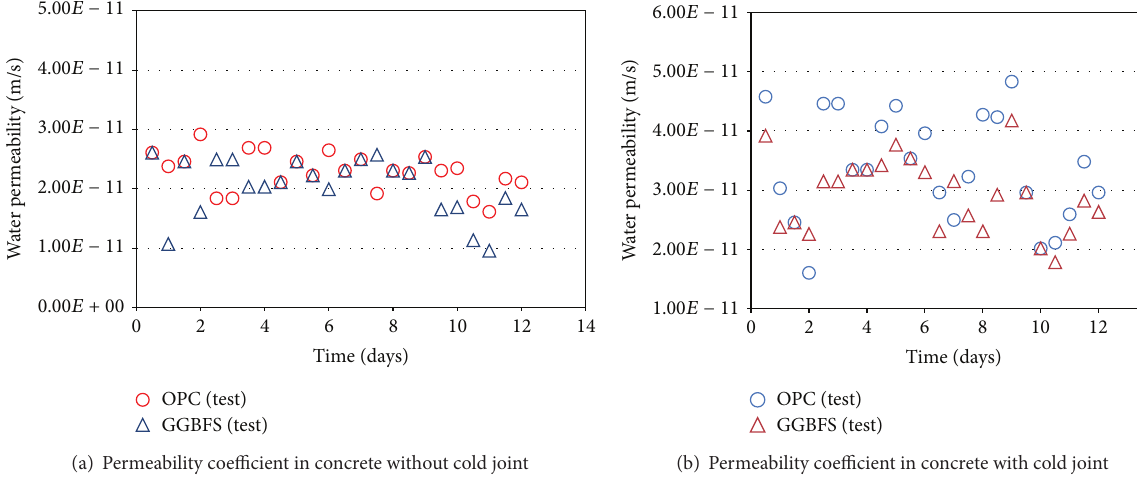
Figure 10: Variations of the measured water coefficient in concrete.